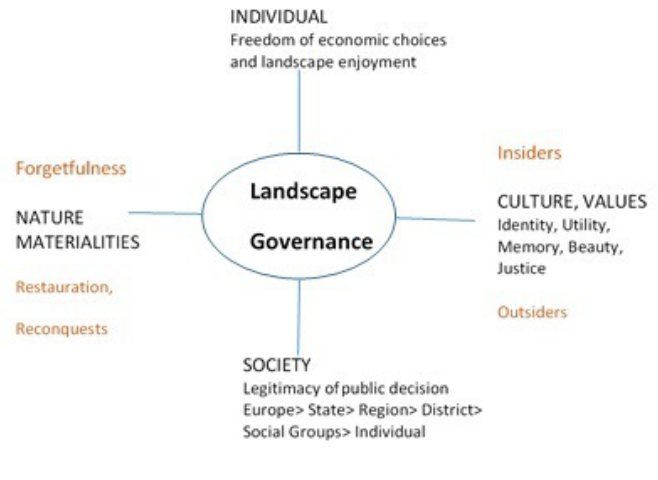
Figure 16: The four pole model for landscape